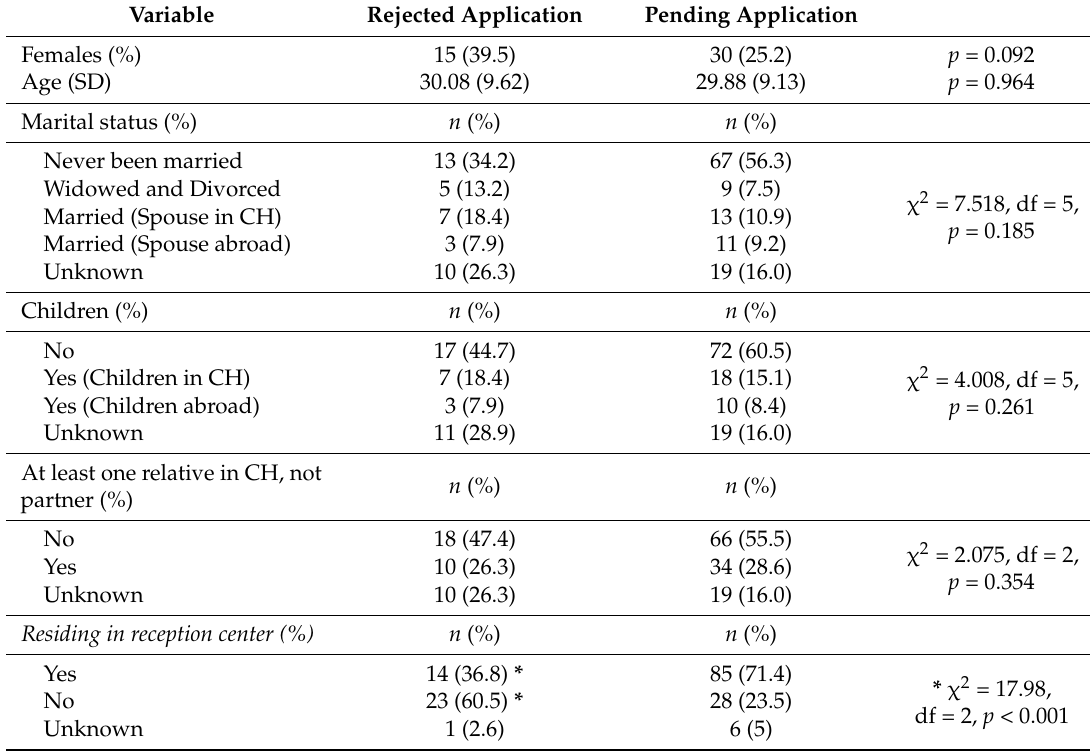
Table 1. The sociodemographic characteristics of patients with rejected ( n = 38) and pending application ( n = 119). Variable Rejected Application